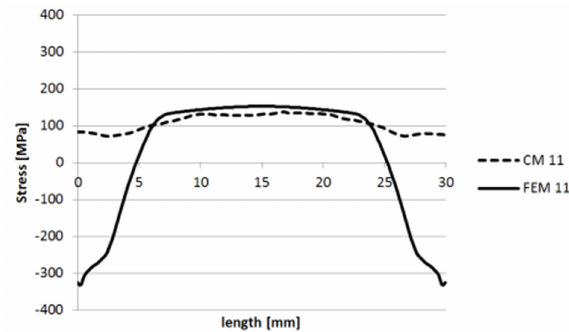
Figure 32. Stress levels in 11 direction along the AB line segment.